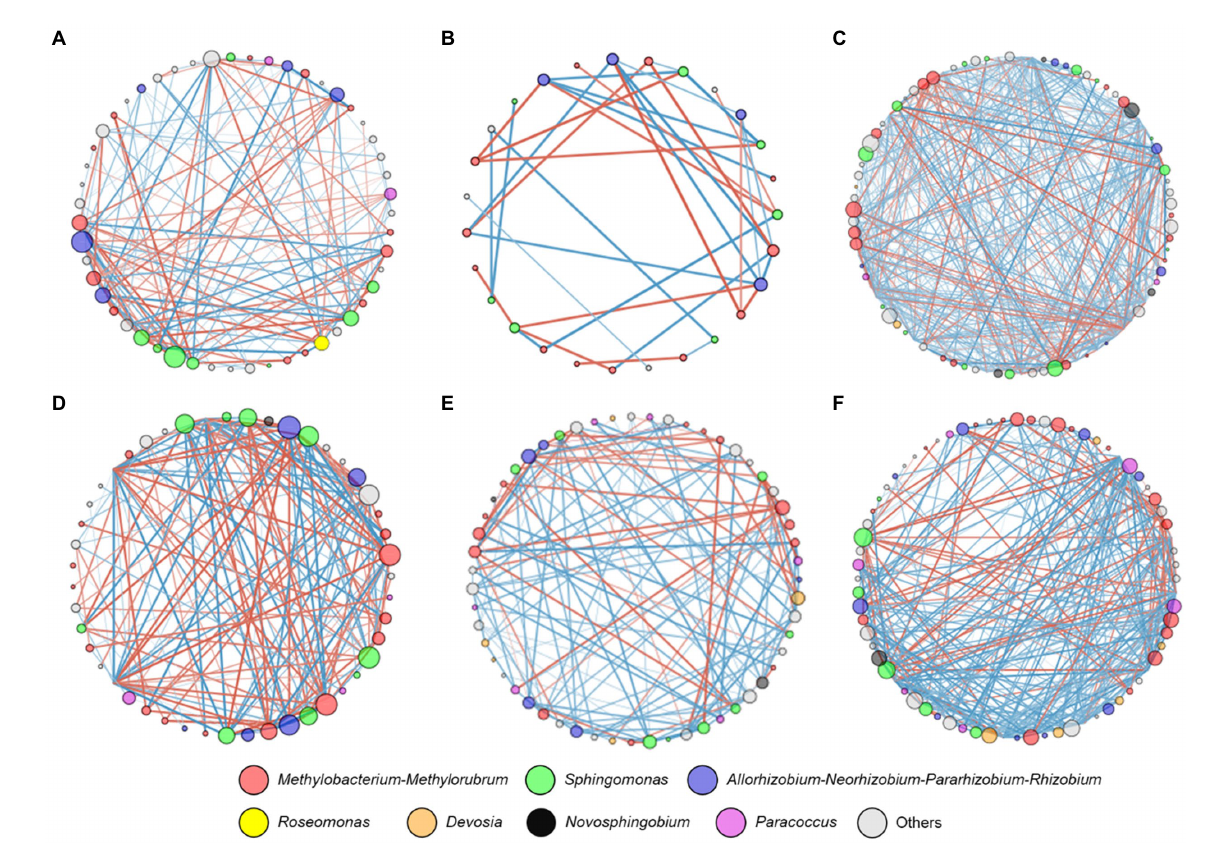
FIGURE 4 Network analyses of alphaproteobacterial communities. A connection stands for a significant ( p < 0.05) correlation between two ASVs. Node sizes represent the number of connections (i.e., degree) and the thickness of lines connecting nodes represents the value of the Spearman correlation coefficients. Red lines represent negative correlations and blue lines represent positive correlations. Different colors represent different bacterial genera. (A) Vitis vinifera L. subsp. vinifera “Müller Thurgau;” (B) Vitis x alexanderi Prince ex Jacques “Isabella;” (C) Vitis labrusca L.; (D) Vitis vinifera L.